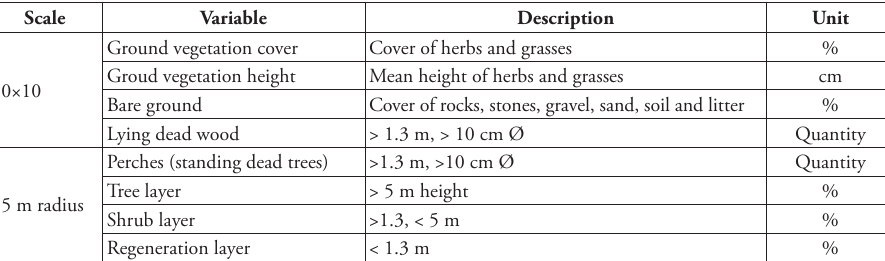
Table 1. Vegetation data were assessed on all occupied and abandoned sites of the European Nightjar in southwestern Switzerland. Ground vegetation and bare ground variables were estimated on a 10 × 10 m plot (mean of four 5 × 5 m plots). On the 15 m-radius plot we counted the number of perches and estimated several vegetation layers on different